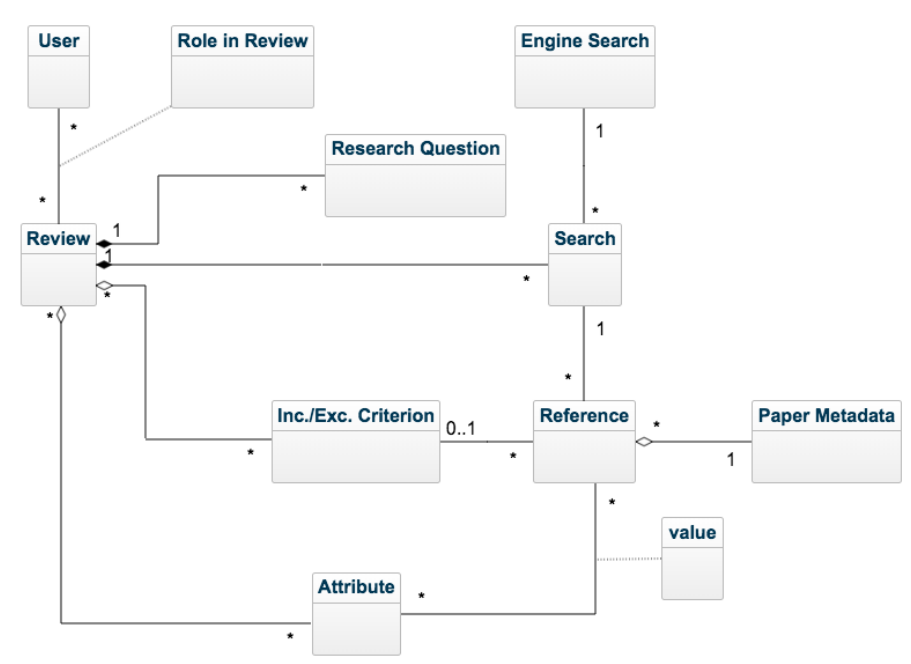
Figure 2. CloudSERA conceptual